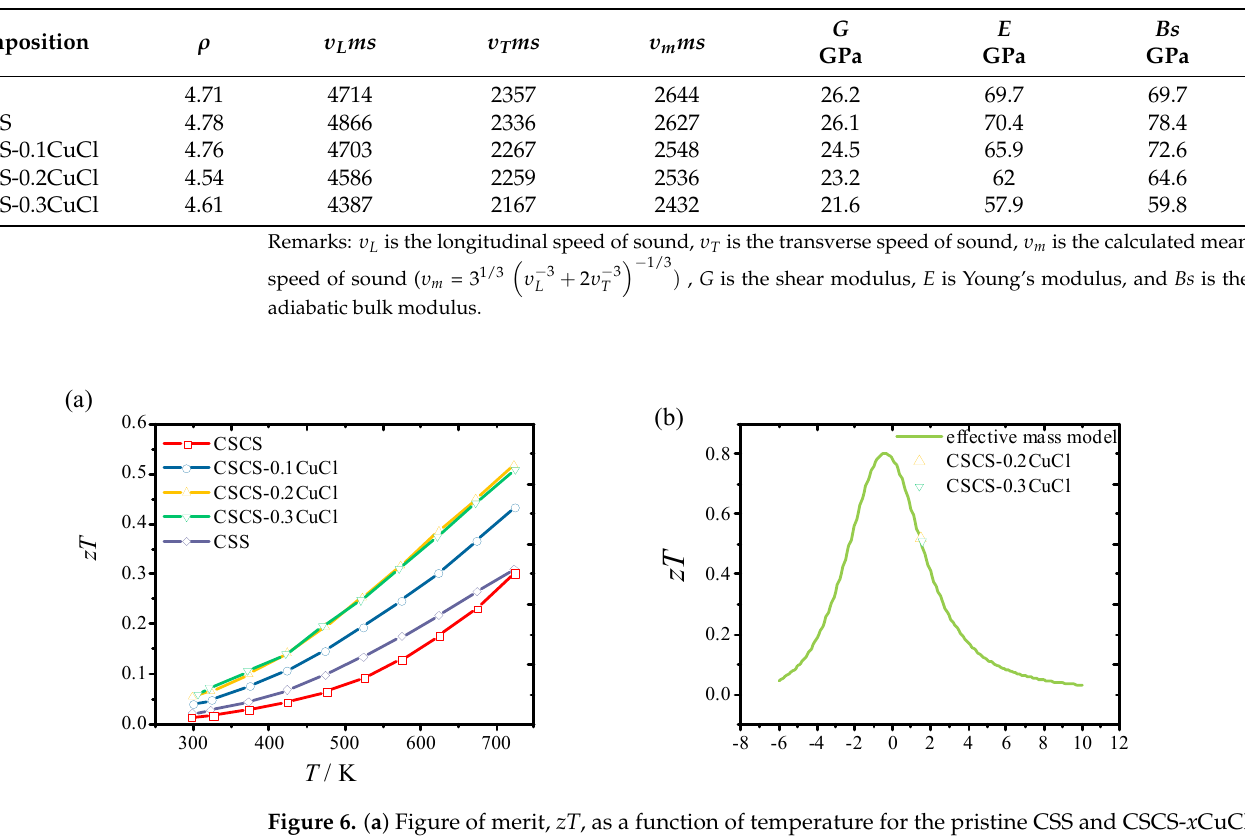
Table 2. Room-temperature speeds of sound and calculated mechanical properties for CSCS- x CuCl ( x = 0, 0.1, 0.2, 0.3) and CSS samples.